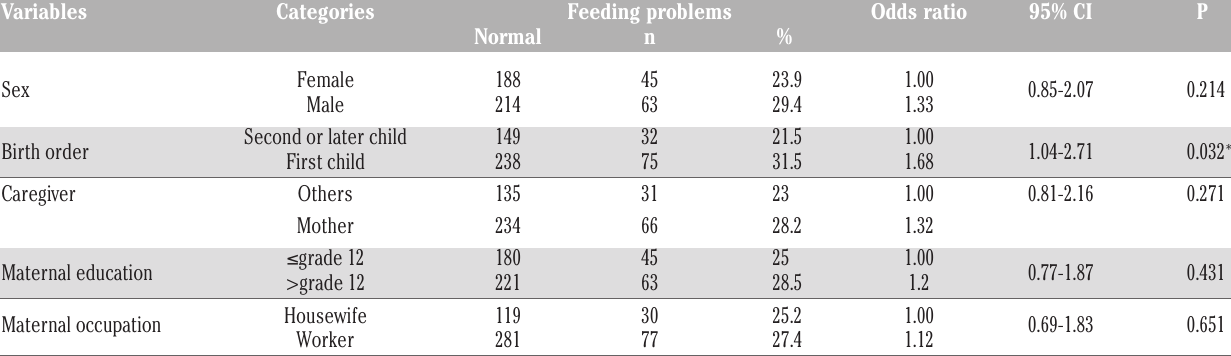
Table 2. Percentage of feeding problems according to socio-demographic characteristics, odds ratios and 95% confidence interval in healthy children attending the well baby clinic of the HRH Princess Maha Chakri Sirindhorn Medical Center.